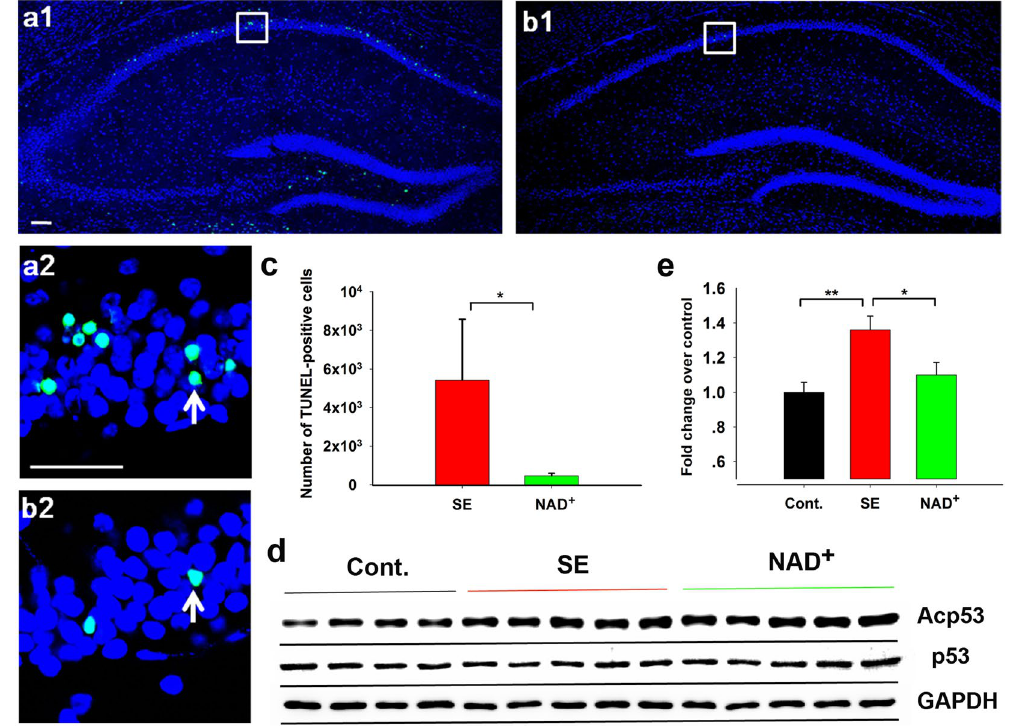
Figure 5. NAD + injection inhibited neuronal apoptosis. ( a 2), ( b 2) Examples of apoptotic neurons in the CA1 region are marked with white arrows. ( c ) The number of double-stained cells (TUNEL-positive and DAPI- positive) of SE model mice (N = 9, S = 6 per mice) and NAD + -treated SE mice (N = 4, S = 6 per mice). Scale bars, 50 µ m. ( d , e ) Western bloting showed that the Acp53/total p53 ratio was significantly increased in SE mice, and NAD + treatment inhibited this increased ratio. Cont., SE, and NAD + represent the control (N = 8), SE model mice (N = 9), and NAD + -treated SE mice (N = 10), respectively. Data are represented as mean ± SEM. * P < 0.05, ** P < 0.01, *** P <